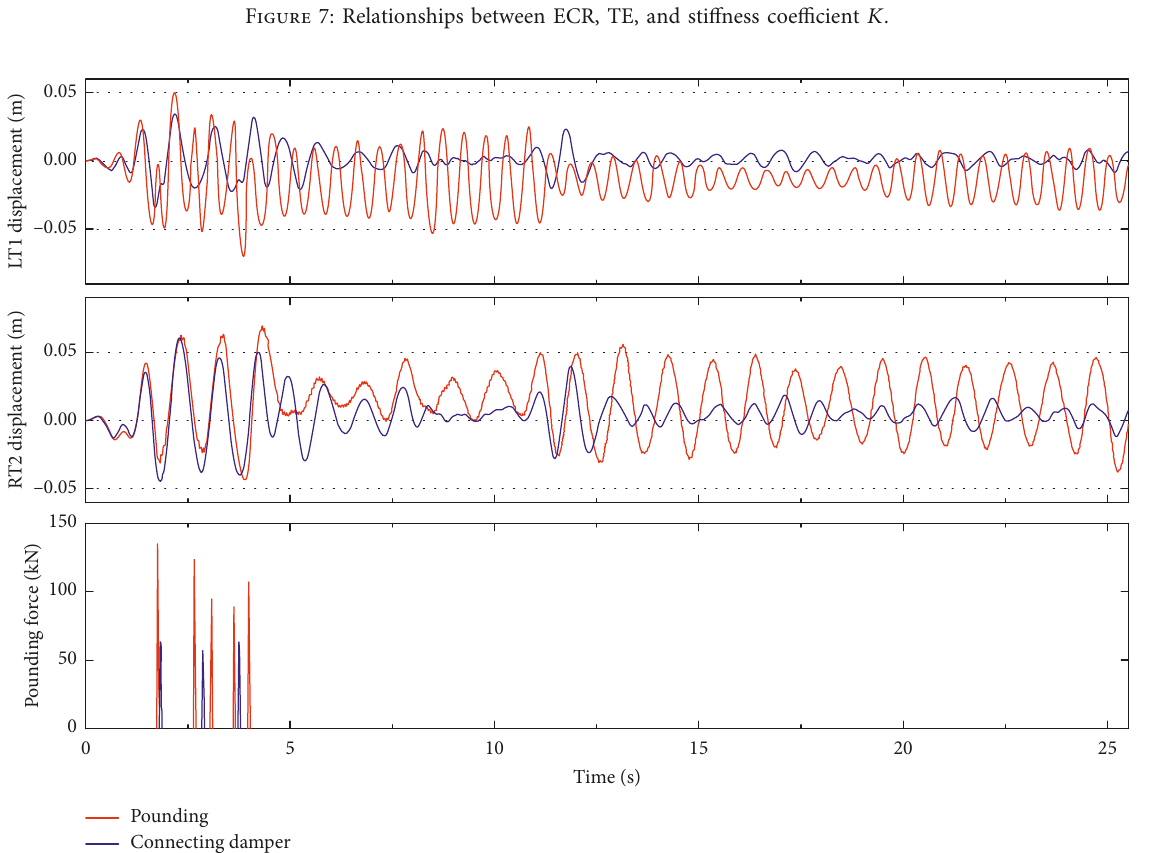
Figure 8: Time-history curves of displacements and pounding forces under ground motion GM2.